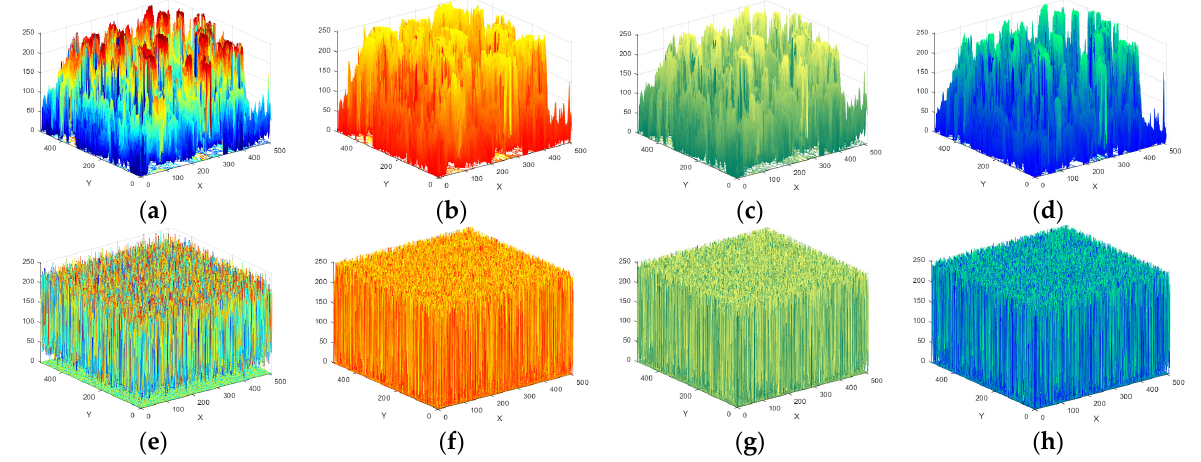
Figure 4. ( a – d ) Three dimensional histograms of the original Tulip image layers; ( e – h ) respective 3D histograms of cipher image layers. histograms of cipher image layers.